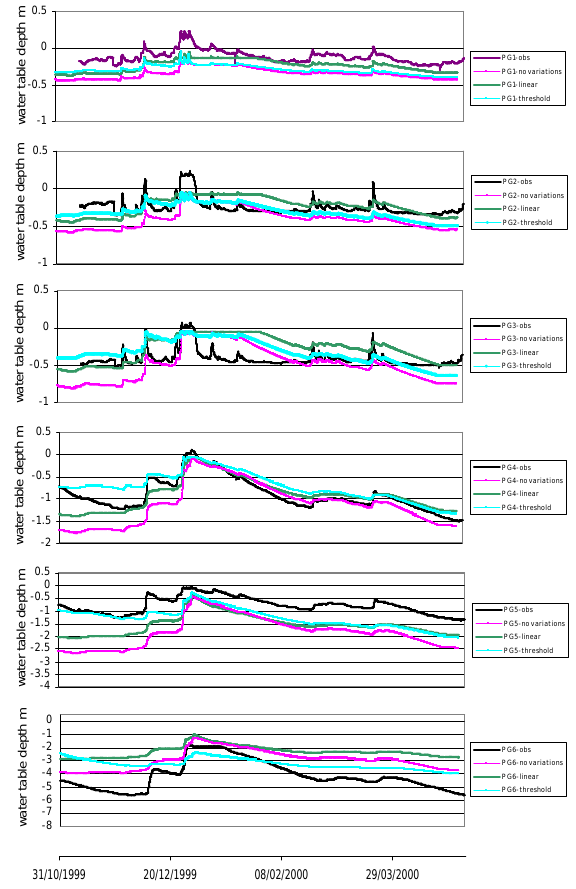
Fig. 8. Observed and modelled hourly variation of water table depth related to the best fits regarding discharge, for six wells and different spatial models of variation in saturated hydraulic conductivity,